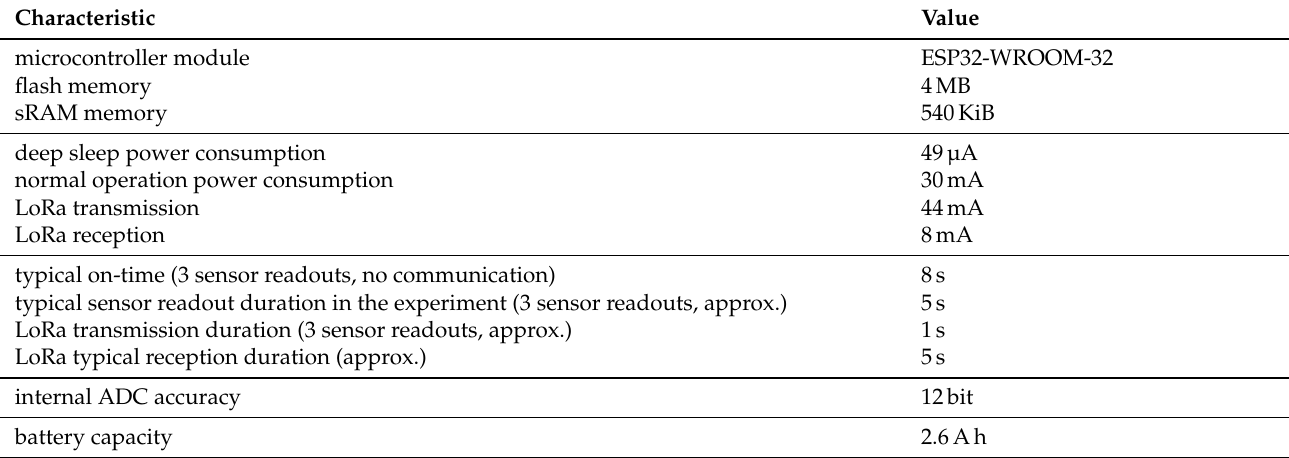
Table 1. Most important technical specifications of a MIRRA sensor node for field measurements and operating time estimations, measured at an ambient temperature of